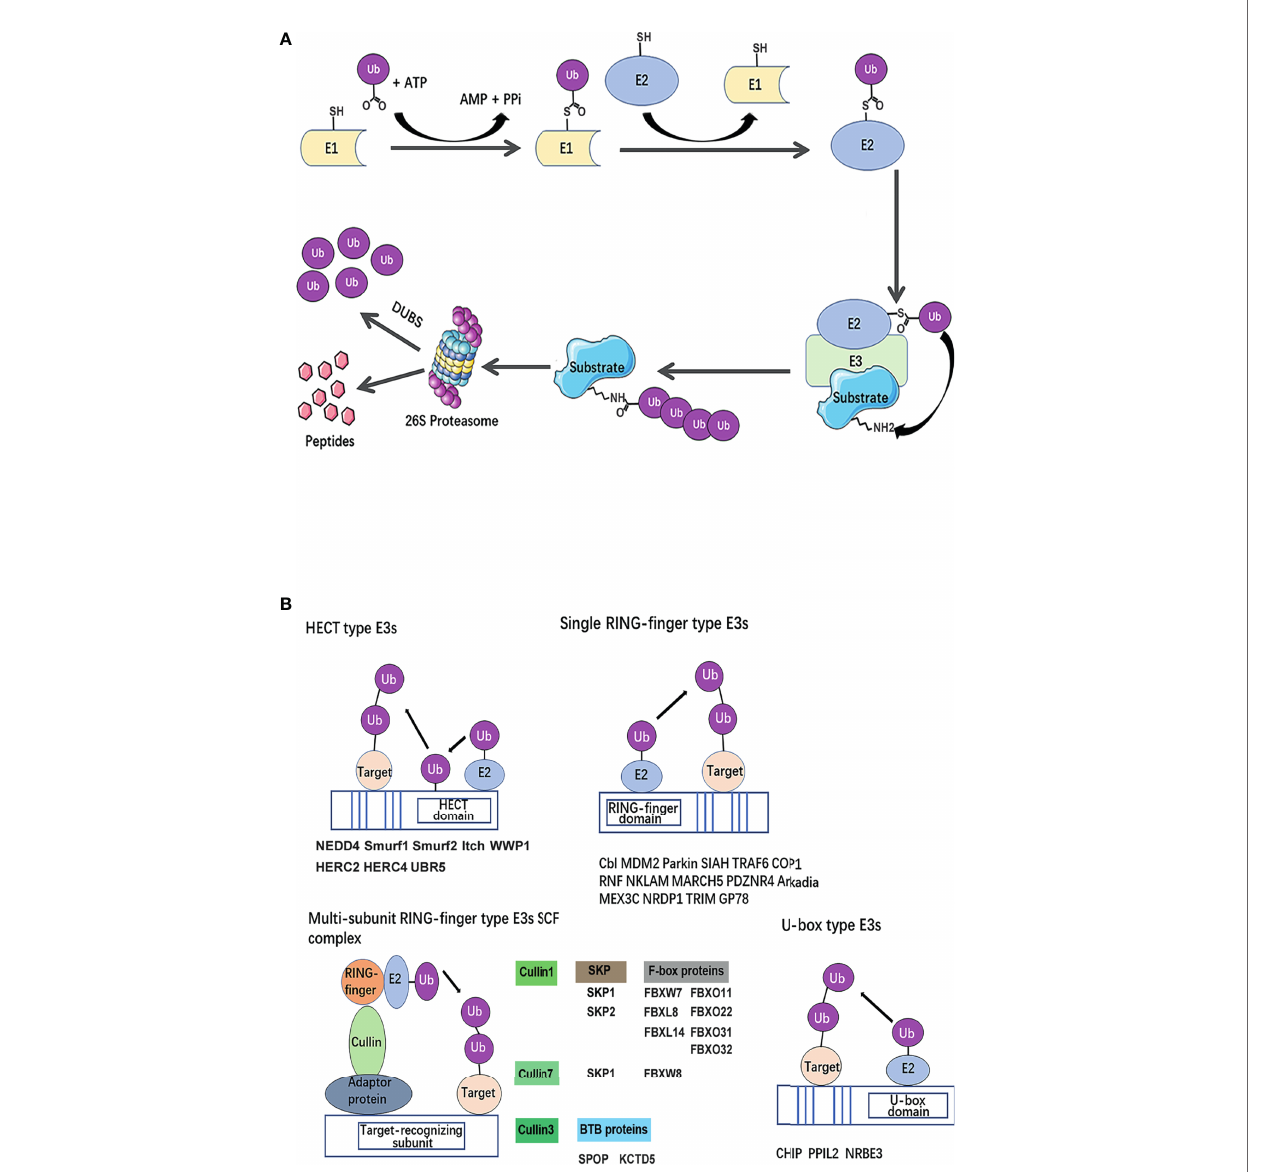
FIGURE 2 | Classical mechanism and structural basis of E3 ubiquitin ligases. (A) The ubiquitin-proteasome system. A ubiquitin-activating enzyme (E1) mediates the activation of the carboxyl-terminal glycine residue of ubiquitin in an ATP-dependent manner. To format the thiolester linkage, the activated ubiquitin is then transferred to E1 followed by the transfer of ubiquitin to a thiolester of a ubiquitin-conjugating enzyme (E2). Ubiquitin protein ligase (E3) confers substrate speci fi city by recognizing the target proteins and mediating the conjugation of ubiquitin molecules to a lysine residue on the targeted protein via an iso-peptide bond. Polyubiquitinated substrate recognized by 26S proteasome for degradation. (B) Classi fi cation of breast cancer metastasis – related ubiquitin E3 ubiquitin ligases based on a structural basis. The canonical E3s are classi fi ed into two canonical types: HECT and RING. HECT E3s contains HECT domains which consist of a E2-interacting N-lobe and a catalytic Cys residue containing C- lobe involved in ubiquitin transfer. RING-type E3s mediate the direct transfer of ubiquitin from E2 to substrate, including single RING- fi nger- type E3s, RING-like (Ubox)-type E3s, and multi-subunit RING- fi nger-type E3s. The Cullin-RING ubiquitin ligase (CRL) family is composed of a multi-unit. Each type of E3s or members of E3 complexes has been summarized and listed below the schematic diagram of the relevant